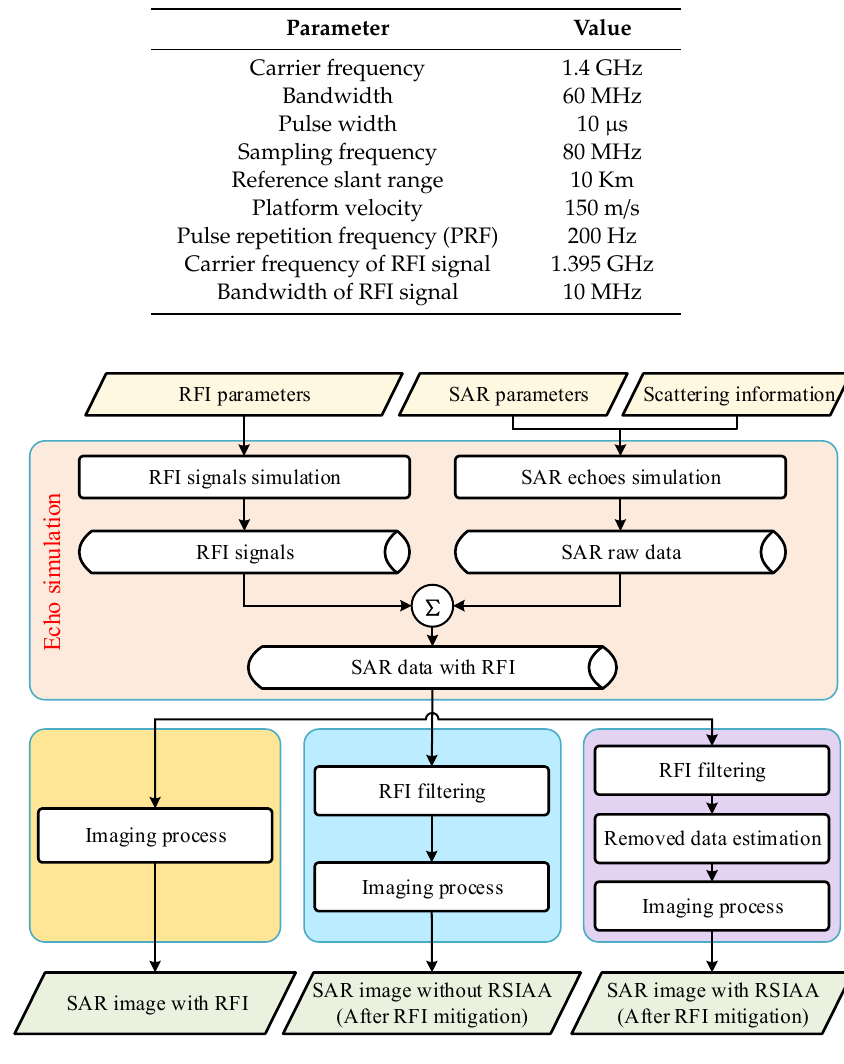
Figure 9. Flowchart of the designed simulation experiments.